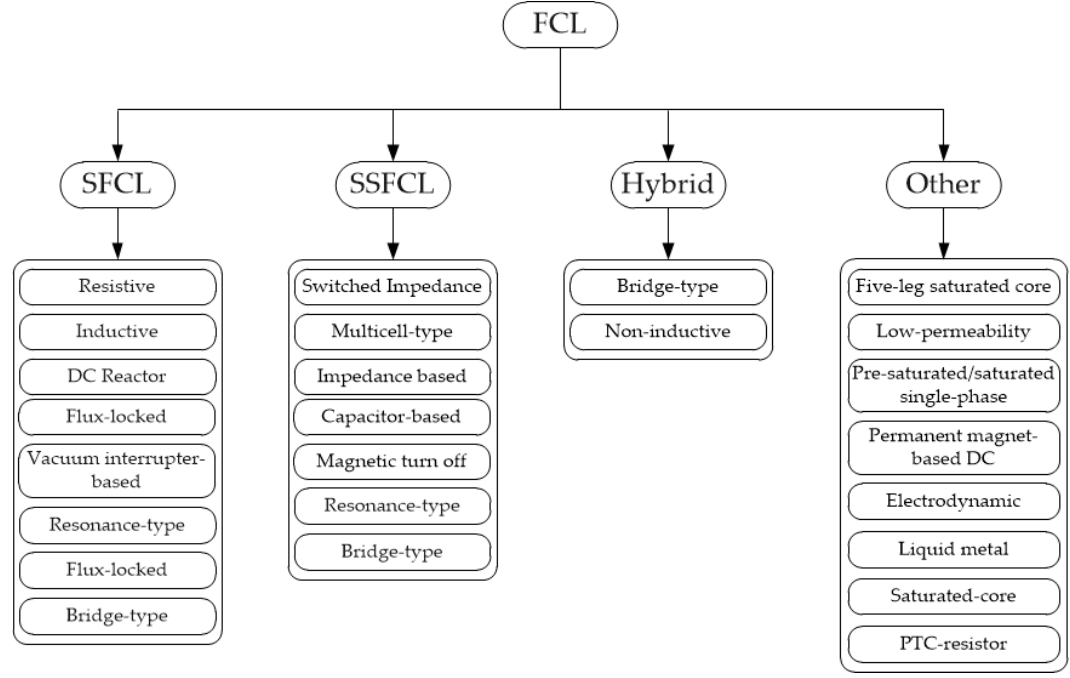
Figure 9. Classification of different types of FCLs [72].